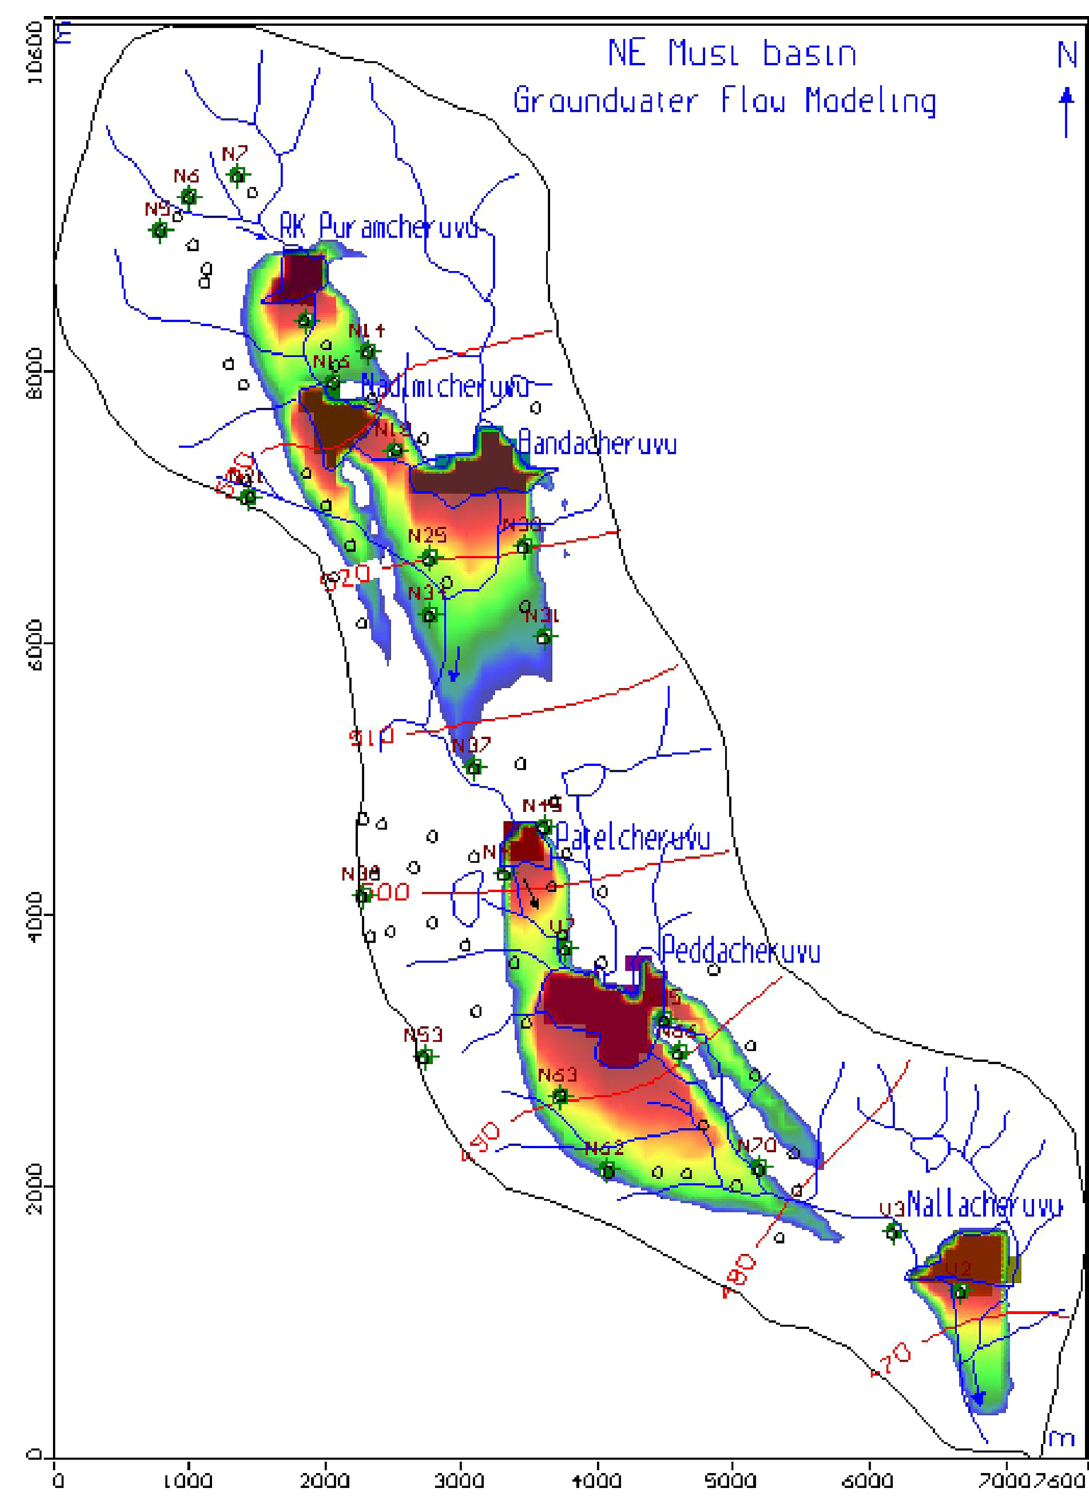
Fig. 12 Predicted TDS concentration of first layer for